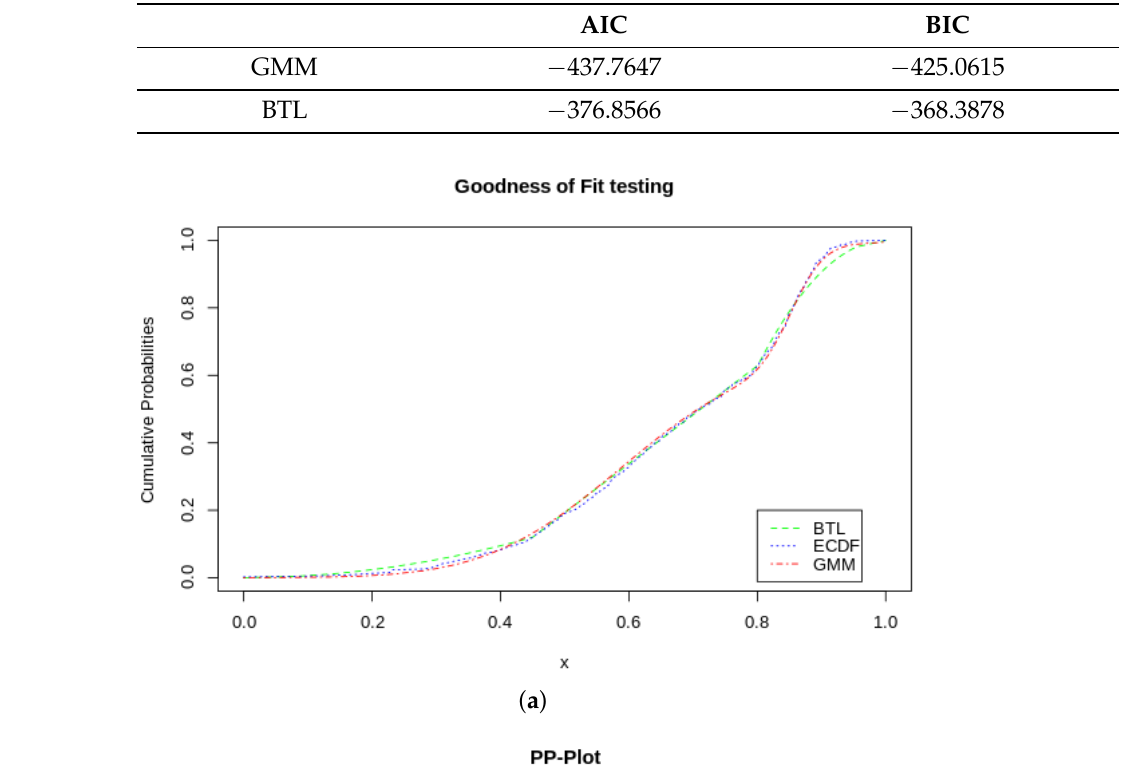
Table 4. AIC and BIC scores.